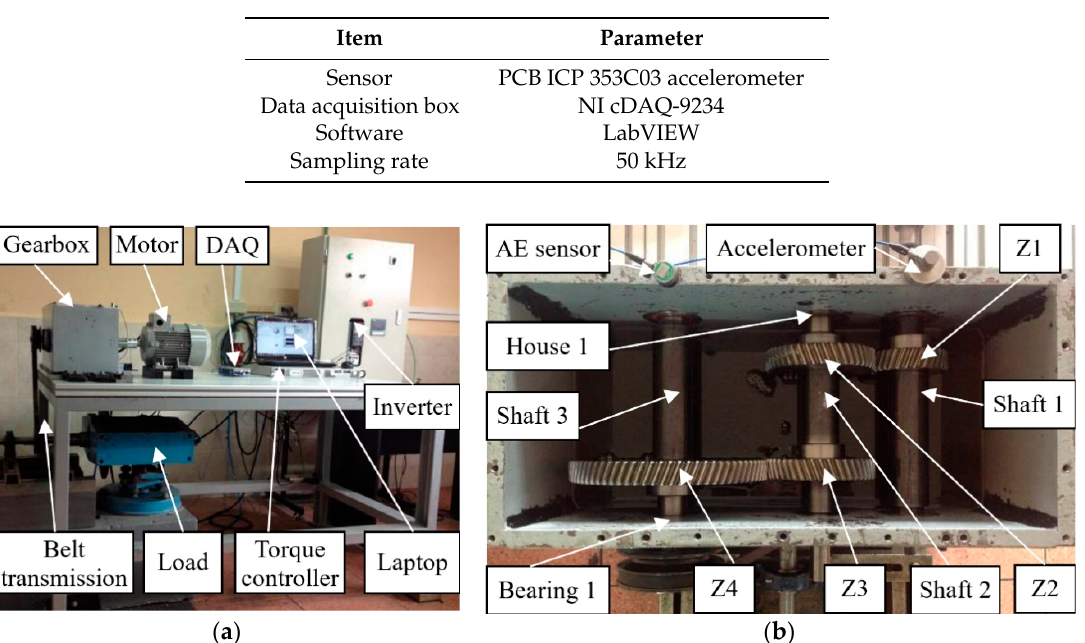
Table 2. Condition patterns of the gearbox.